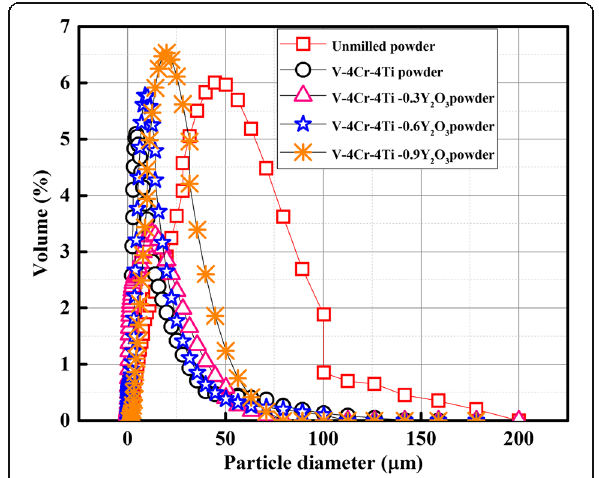
Fig. 2 Laser particle analysis of unmilled, milled, and yttria-dispersed V – 4Cr – 4Ti powders